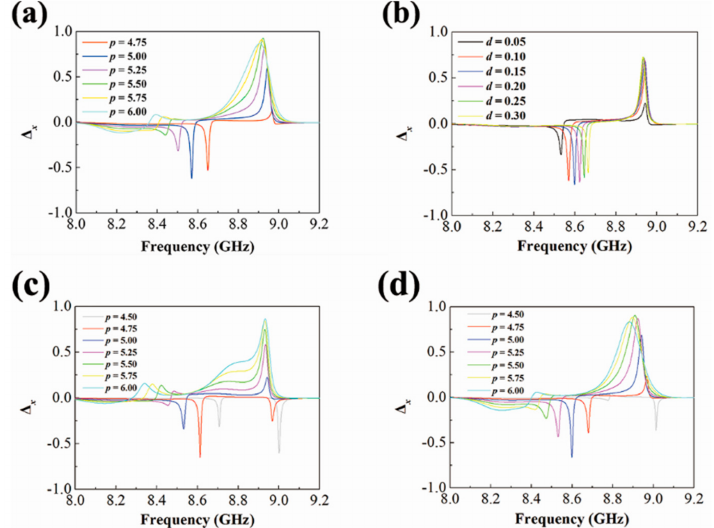
Figure 5. Dependence of the asymmetric parameter, ∆ x , on the two geometrical parameters. ( a ) The lattice constant, p , when d = 0.10 mm. ( b ) The thickness of the spacer, d , when p = 5.0 mm. ( c ) The lattice constant, p , when d = 0.05 mm. ( d ) The lattice constant, p , when d = 0.15 mm.